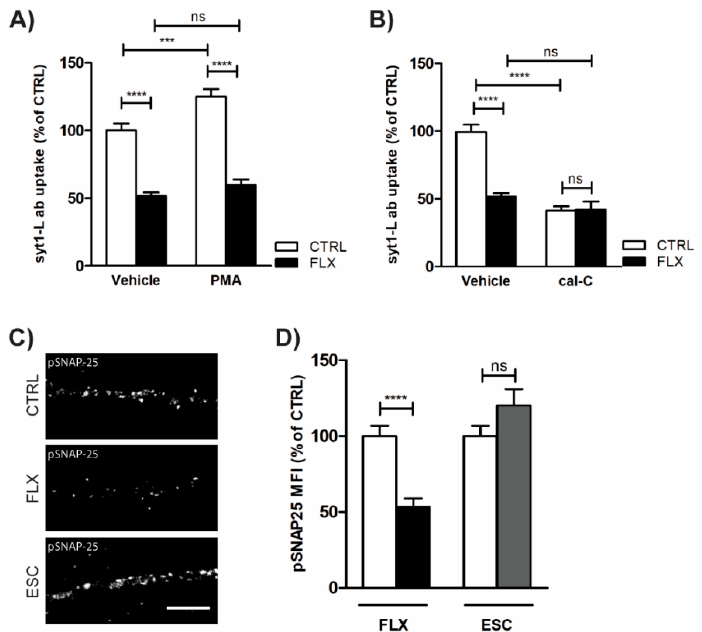
Figure 5. Impaired PKC activity may account for FLX-induced aberrant neurotransmission. ( A